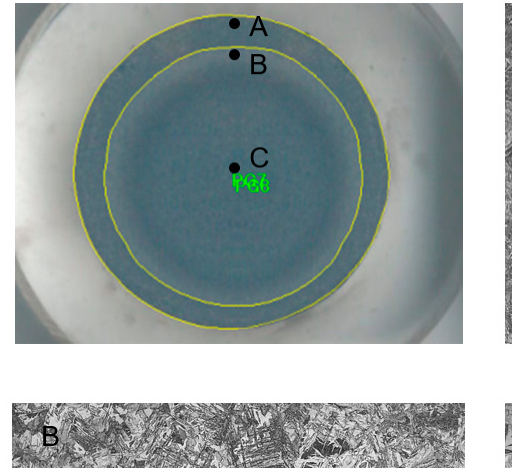
Table 4. Performance test with respect to alloy